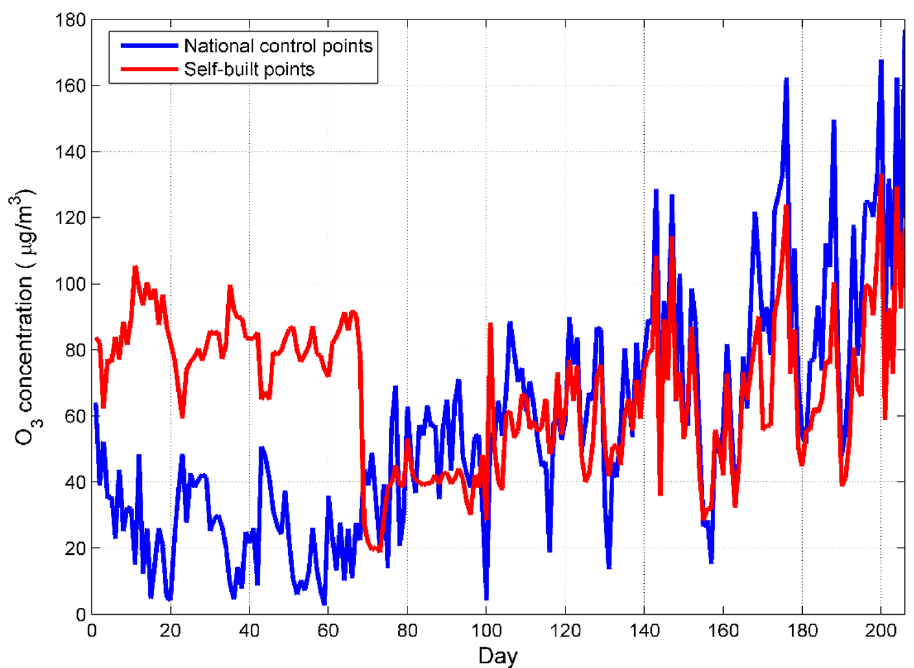
Figure 1. Comparison of daily average O 3 concentration data between national control points and self-built points. Figures are generated using Matlab (Version R2016a, https:// www. mat- hworks.com/)